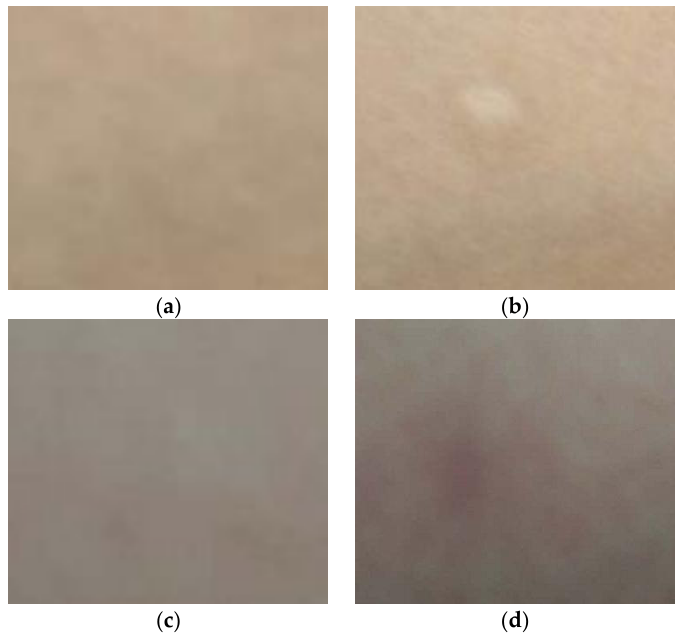
Figure 10. Pictures of the skin surface before and after each experiment. ( a , b ) Before and after experiment, respectively, with application of electroporation (pulse voltage density = 60 V/cm 2 , pulse width = 10 ms; number of pulses per second = 10); ( c , d ) Before and after experiment, with application of reverse iontophoresis (Symmetrical biphasic dc, current density = 0.3 mA/cm 2 ; reversed every 3 min during the 12 min).